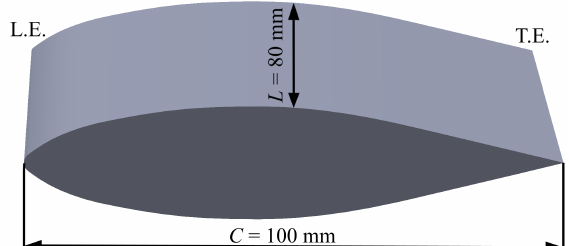
Figure 1. 3D model of hydrofoil section. L.E. and T.E. stand for leading and trailing edges of hydrofoil, respectively.